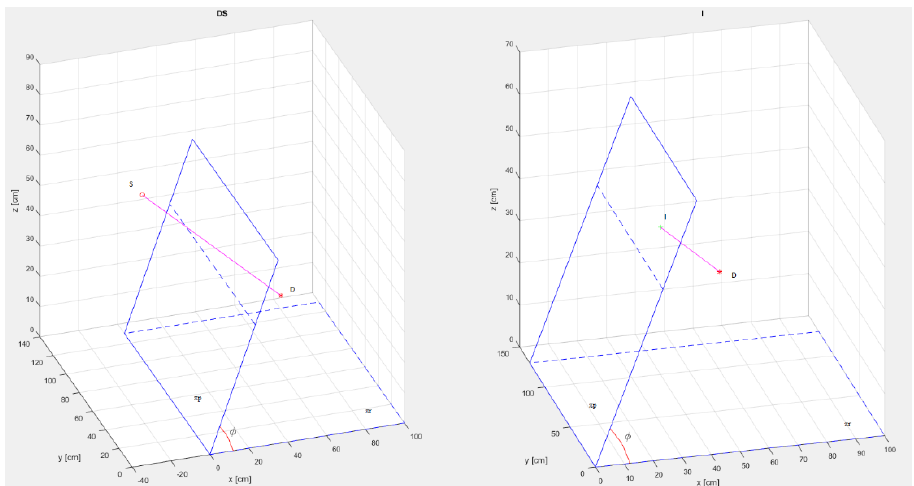
Figure 13. Test scenario 1—sun (S) and driver’s eye (D) are fixed points.